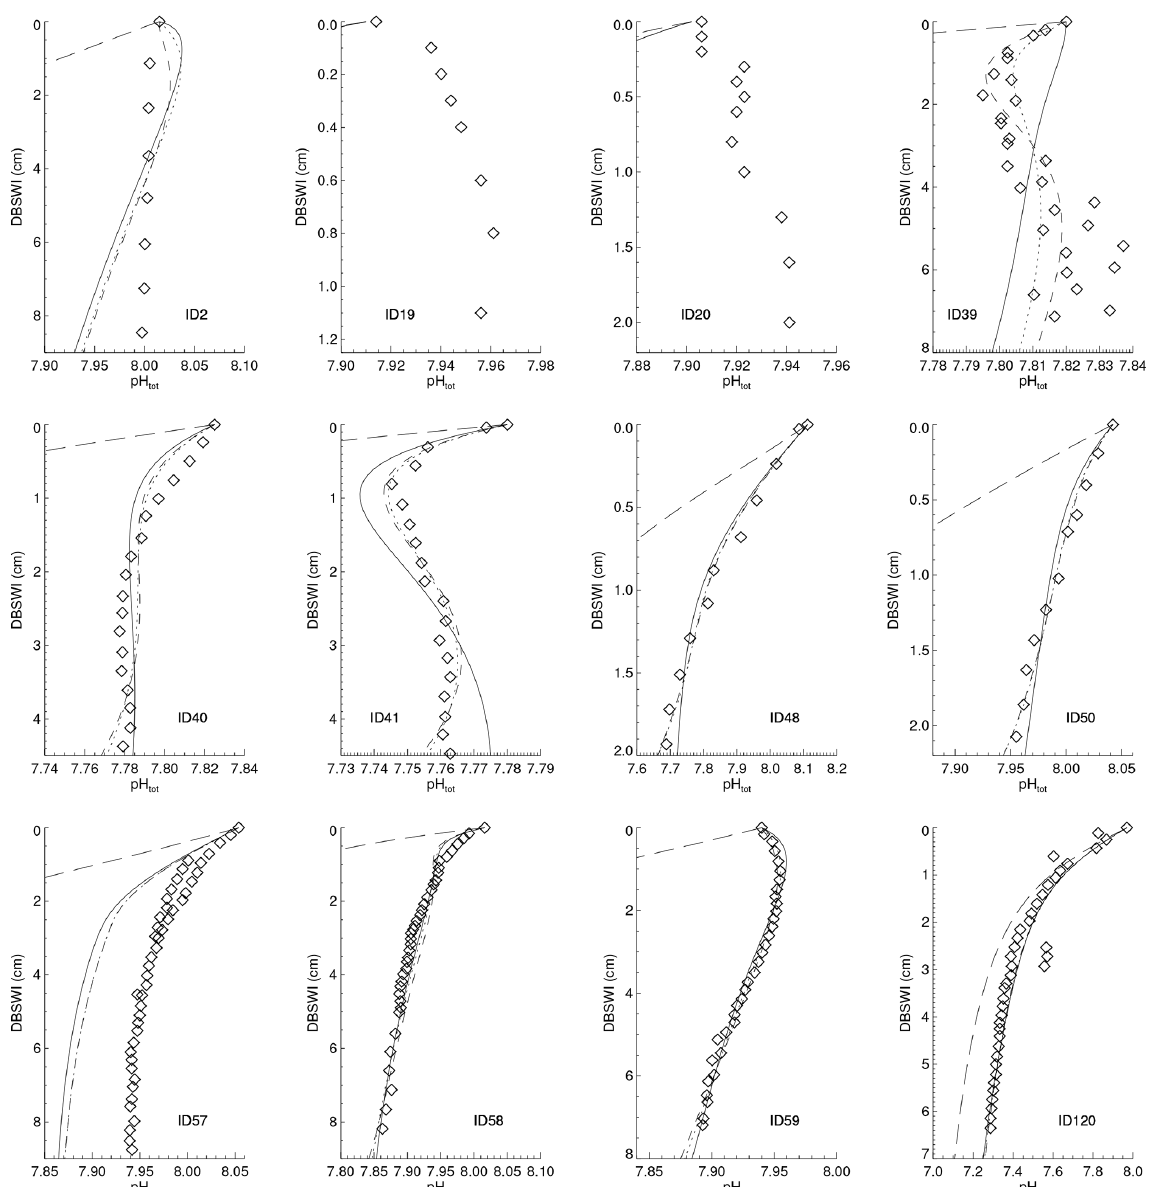
Figure 6. The pH profiles for experiments with calcite mass fractions in the deposition flux limited to 90%. Lines are as follows: long dashed – no calcite dissolution; full – calcite dissolution kinetics of order 4.5; dotted – order 2; short dashes –